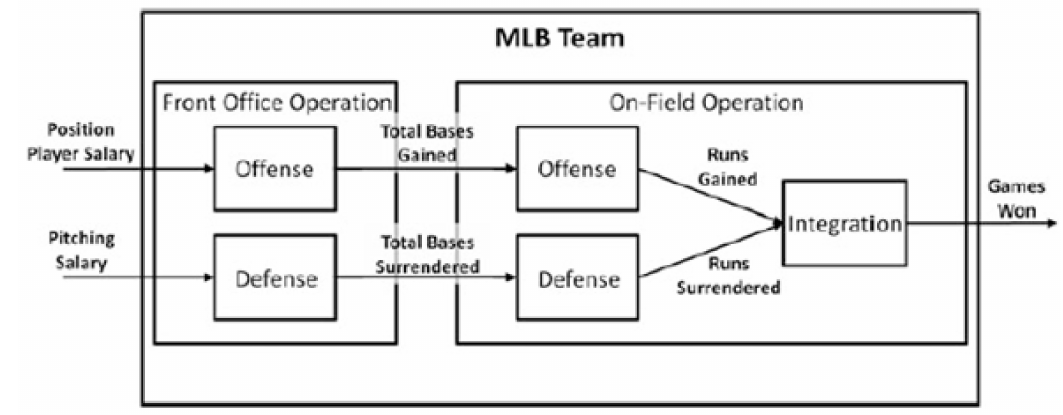
Figure 3. Network DEA model for the comprehensive examination of MLB team operations e ffi ciency [12]. Reproduced with permission from Cook, W.D., and Zhu, Data Envelopment Analysis: A Handbook on the Modeling of Internal Structures and Networks; published by Springer: New York, NY,